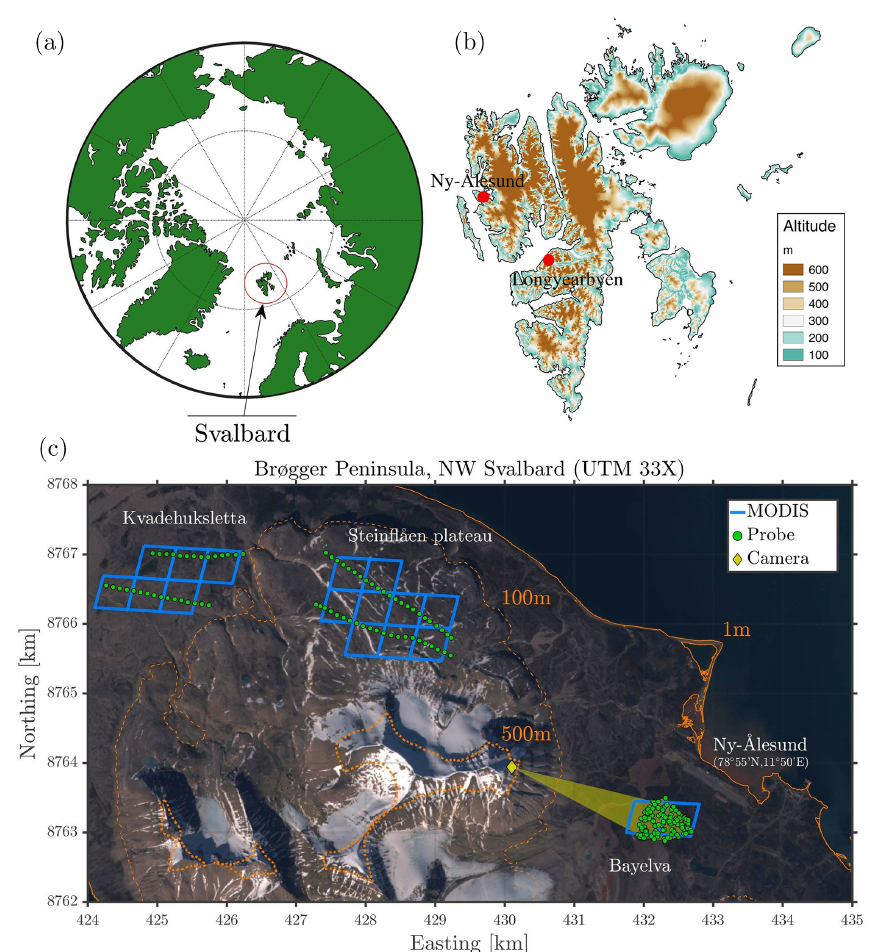
Figure 1. (a) location of Svalbard (in red) in the Arctic. (b) Map of Svalbard; the study area is close to Ny-Ålesund. Bottom: Sentinel-2A true-color image (2 July 2016) of the western Brøgger Peninsula with the three study sites Kvadehuksletta, Steinflåen plateau and Bayelva; green dots: snow survey probe locations; blue polygons: MODIS pixels; yellow diamond: automatic camera system on Scheteligfjellet; yellow shading: field of view of the camera; contour lines courtesy of the NPI (2014)